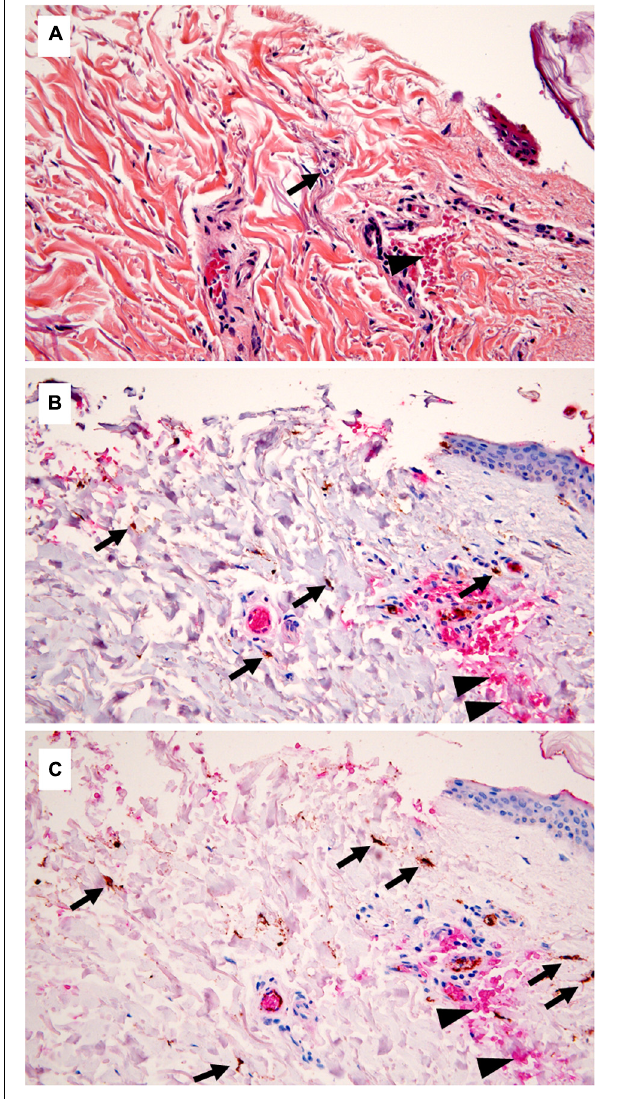
FIGURE 1 | Standard histology and immunohistochemistry (IHC) in a medicolegal wound. (A) Standard histology showing only one polymorphonuclear (PMN) (arrow) close to the wound margin, and hemorrhagic infiltration (arrowhead) (hematoxylin, eosin, and saffron, × 400 magnification). (B) Double staining for myeloperoxidase (MPO) and glycophorin C, underlining the presence of several inflammatory cells